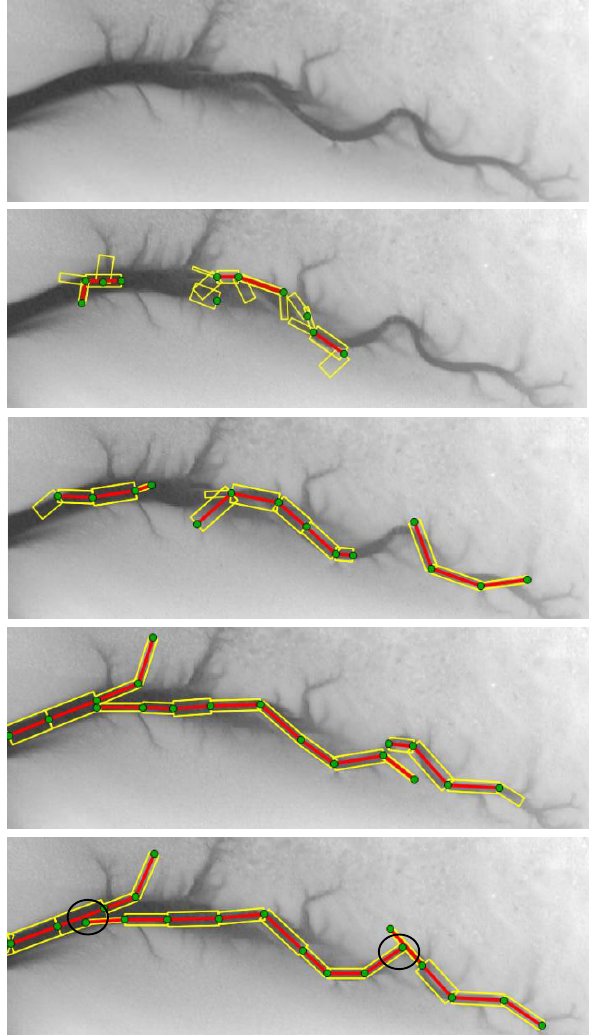
Figure 4: DTM with tidal channels (top) and the results after , , and iterations. The optimized segments are depicted in yellow, the nodes and edges of the graph are shown in green and red.